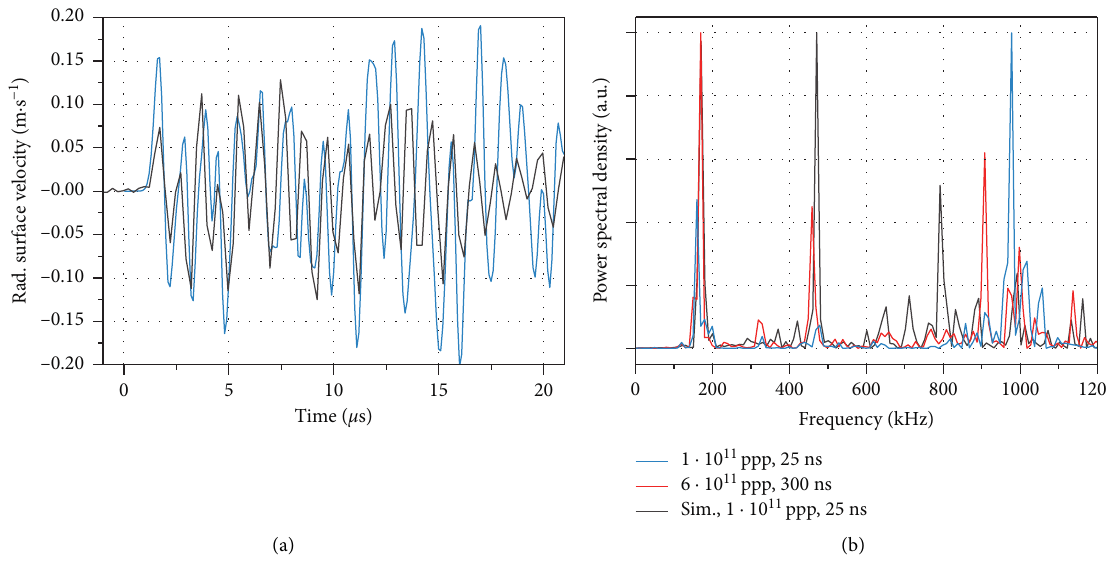
Figure 7: Comparison between experimental and simulation results for sample #1 SGL R6650. Experimental (black) and simulated (red) radial surface velocity as a function of time for 20 μ s after beam impact for a beam intensity of 1 × 10 11 ppp (a). Normalized power spectral densities for the first 100 μ s after beam impact of the simulation and the experiment at two different beam intensities